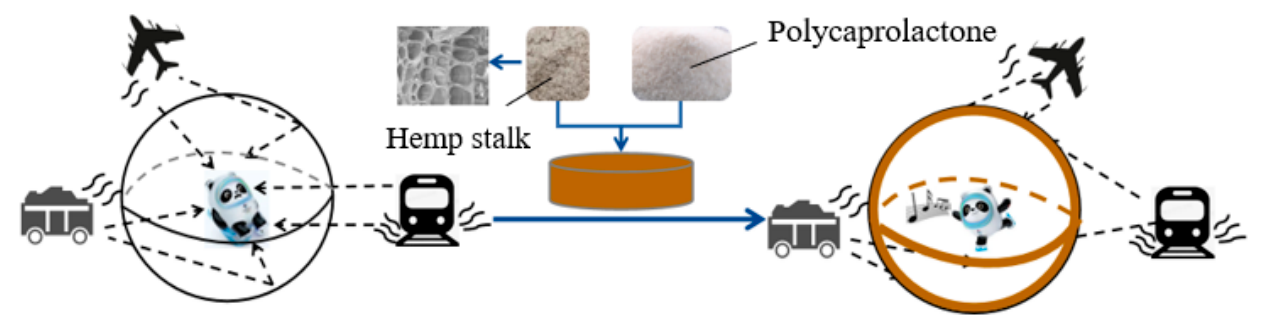
Figure 1. Schematic diagram of research significance and application.